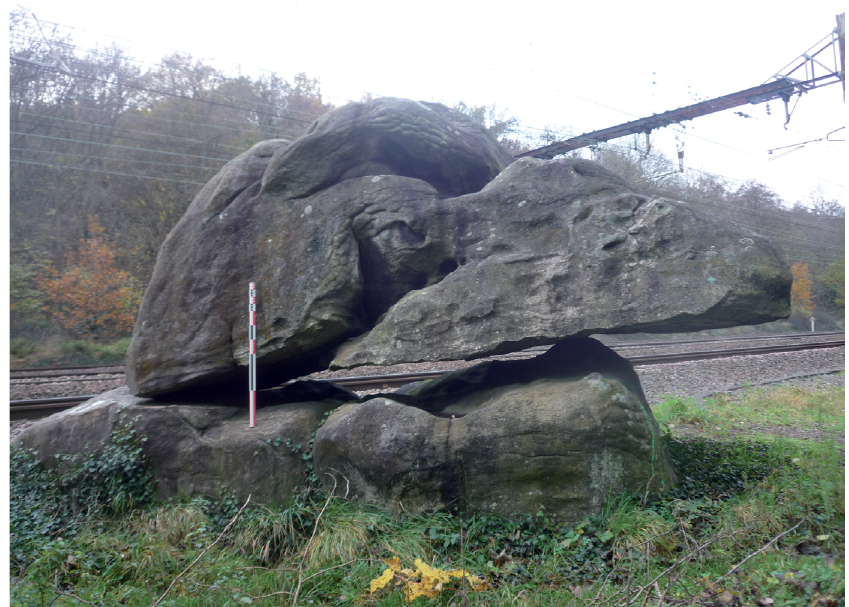
Figure 13. The Roche-qui-Tourne in Lardy (Essonne). © J. Bruant/Inrap.